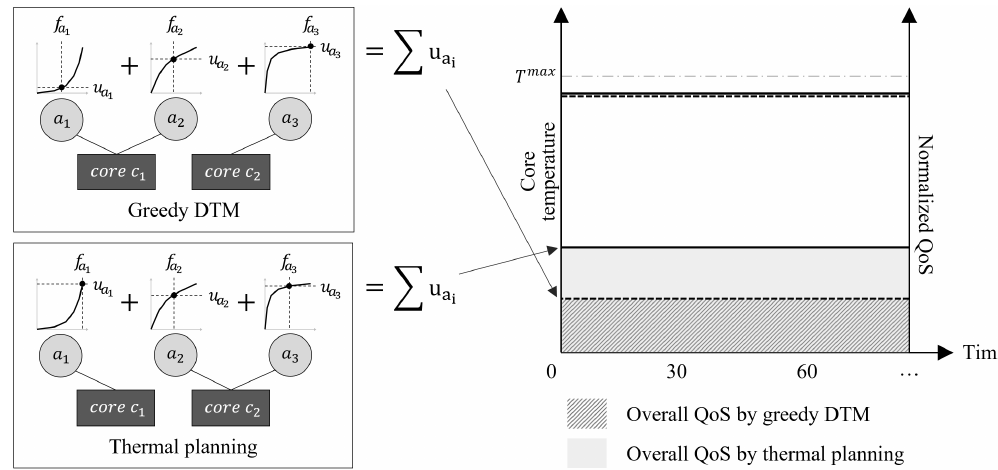
Figure 12. Steady QoS gain of our thermal planning compared with the greedy